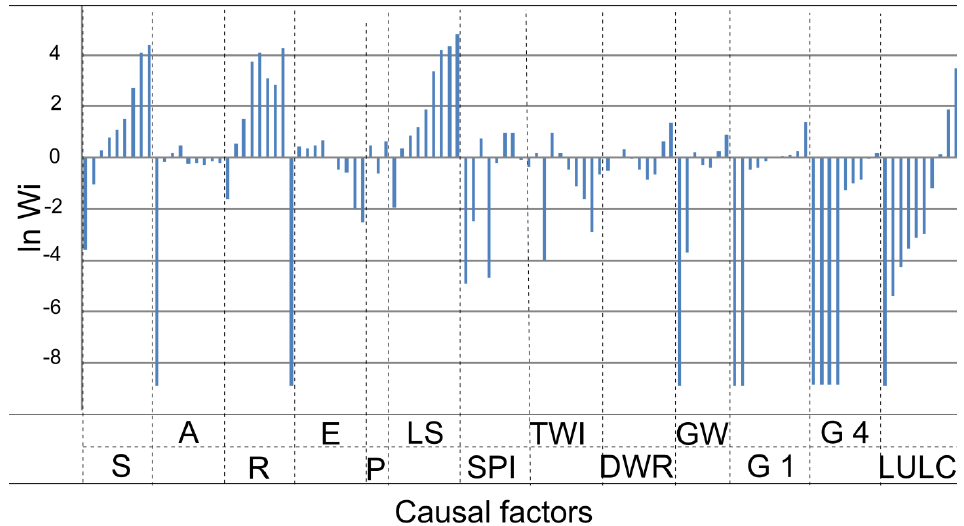
Figure 9. Importance of the conditioning factors for all landslides by the landslide susceptibility index (LSI) for entire landslide area in Gdynia.